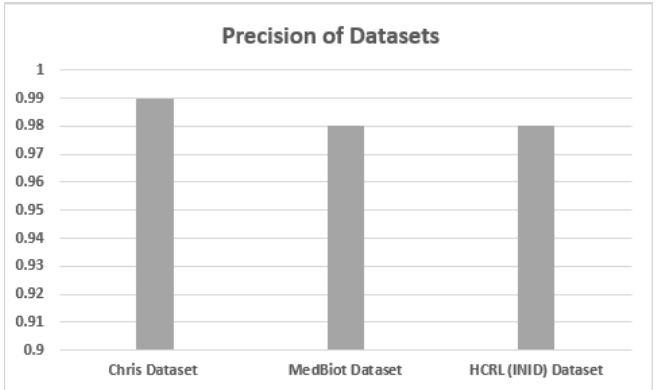
Figure 6. Accuracy of different datasets.